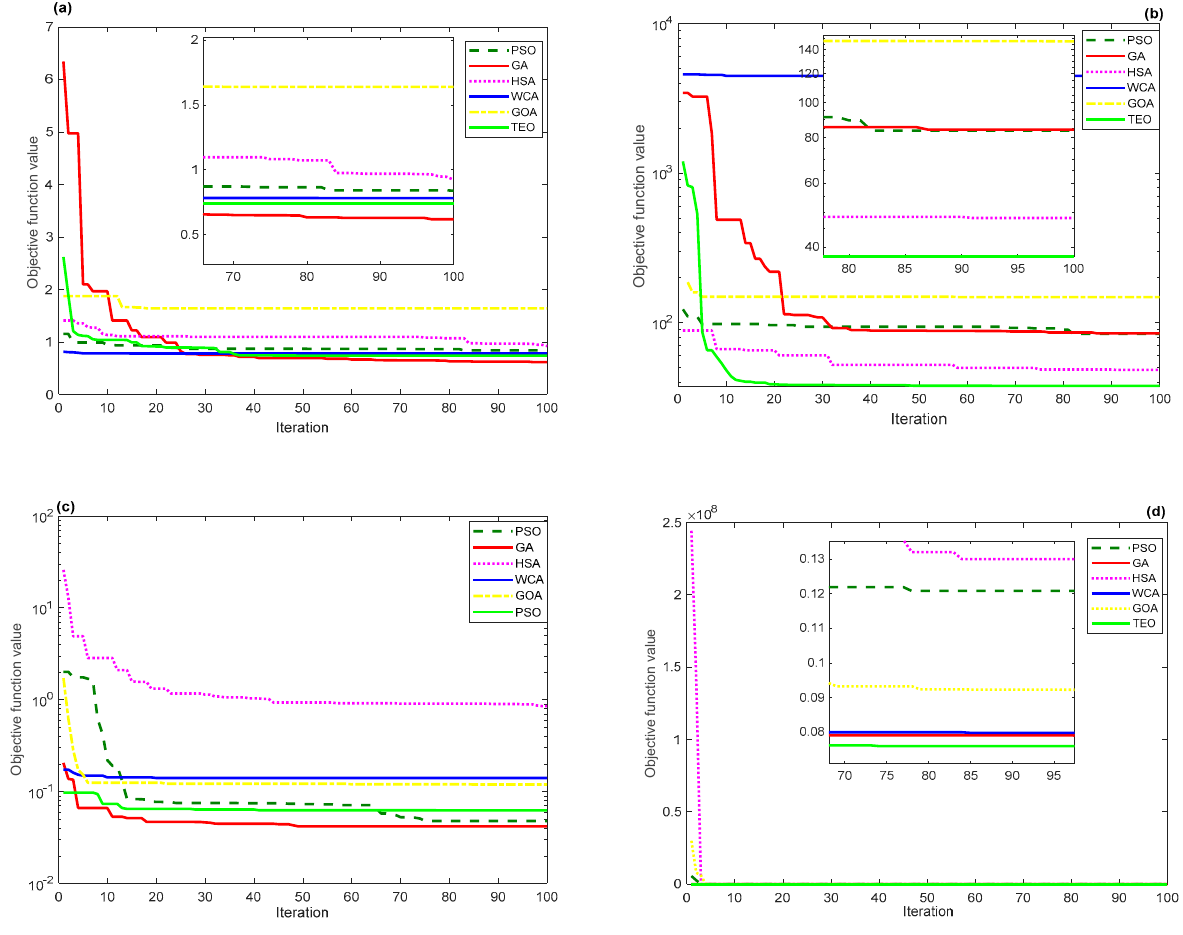
Figure 4. Convergence curves comparison: ( a ) IAE; ( b ) ISE; ( c ) ITAE; and ( d ) ITSE criterion. Since the TEO metaheuristic outperformed all the other reported ones, the effective gains λ dc and α dc of the STA-SOSM controller, retained for the rest of the control strategy, are selected as the best results obtained by the TEO algorithm of the optimization problem (16) and (17). Table 2 summarizes such decision variables for each time-domain performance criterion. Table 2. TEO-based results for the STA-SOSM controllers’ gains tuning. Performance Criteria